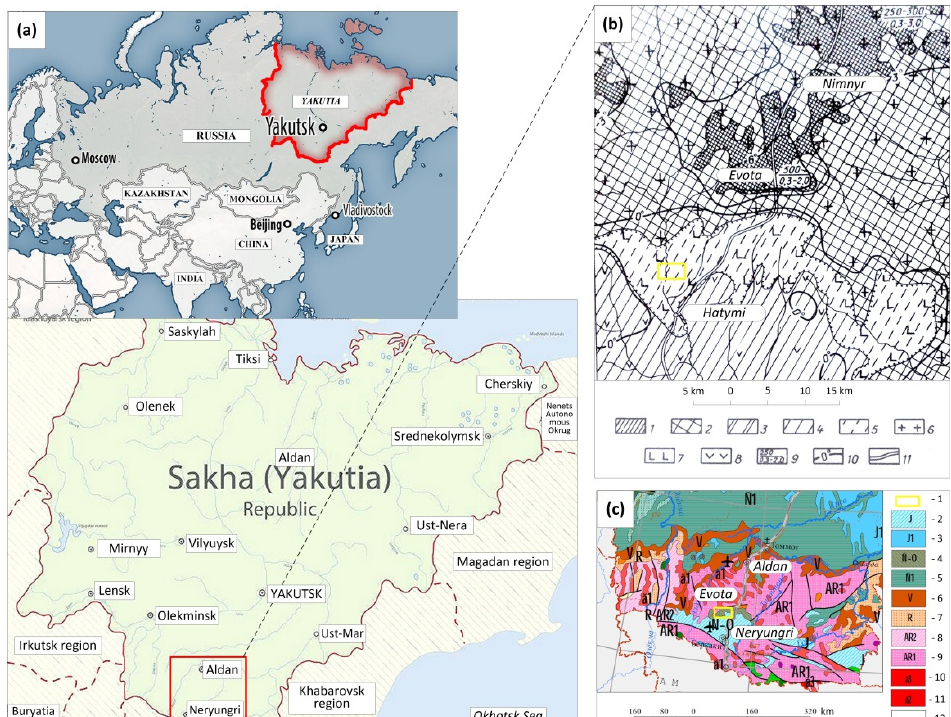
Figure 1. Overview map of the study area: ( a ) location of the study area; ( b ) geocryological scheme of the research area (according to V.R. Alekseev, 1963 [22]). The yellow outline marks the bounda- ries of the study area. Types of permafrost rocks by the degree of discontinuity: 1—continuous